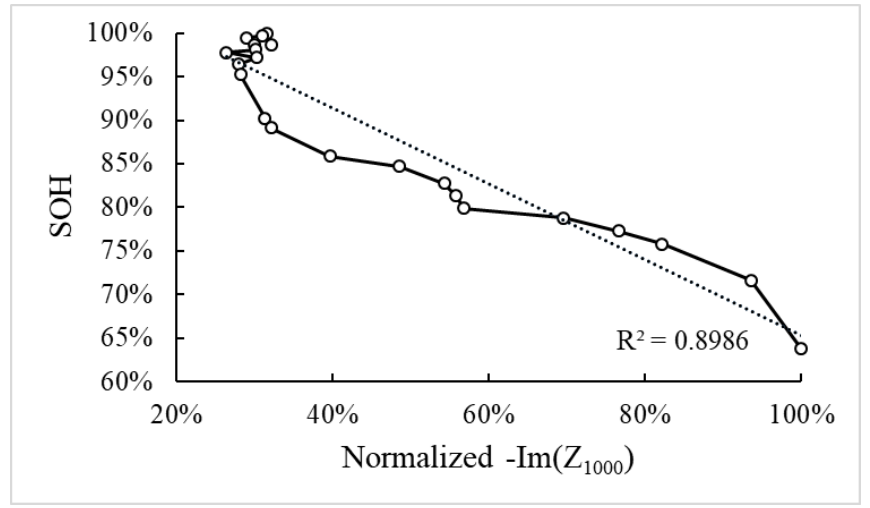
Figure 10. The correlation between the reactance at 100 Hz and the SOH.